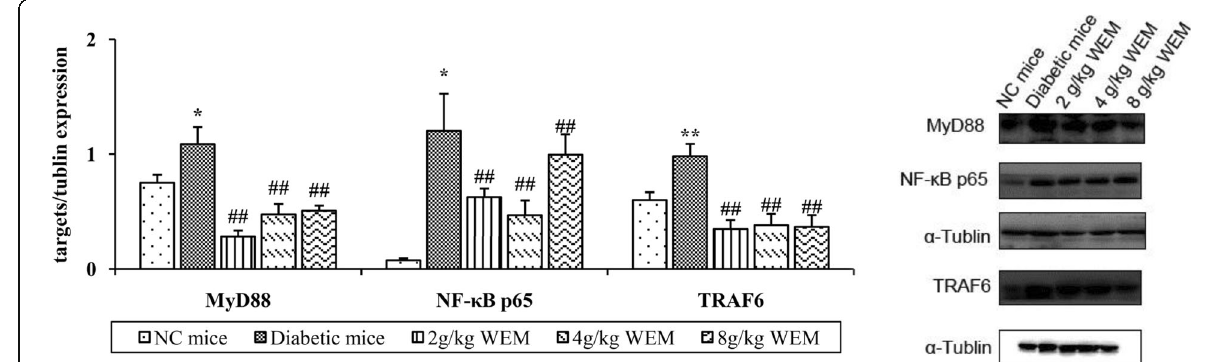
Fig. 8 Downstream transcription factors ’ expression interfered with WEM in diabetic mice. An evident decrease in MyD88 was detected after the treatment. According to the downstream transcription factor TRAF6 activation with WEM in diabetic mice, a profound decrease in TRAF6 was shown after the treatment. According to the downstream transcription factor NF- κ B p65 activation with WEM in diabetic mice, NF- κ B p65 expression showed a huge reduction after the treatment. Normalized results are expressed as means ± SEM ( n = 3). * P < 0.05, **P < 0.01, NC mice vs. Diabetic mice; # P < 0.05, ## P < 0.01, WEM vs. Diabetic